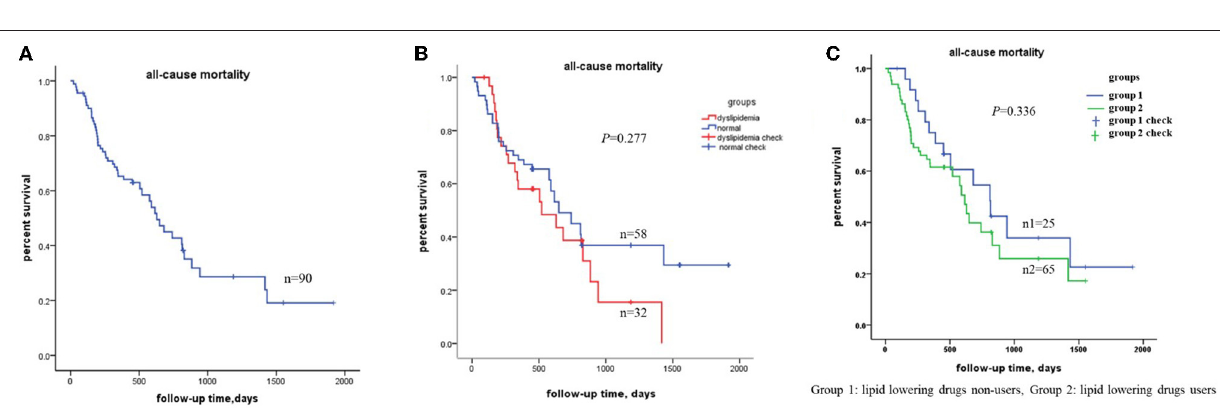
intensive LDL-C lowering can reduce the risk of all-cause and cardiovascular mortality for ASCVD patients (16). The lipid status and the association between LDL-C level and all-cause mortality in inpatient centenarians are still poorly